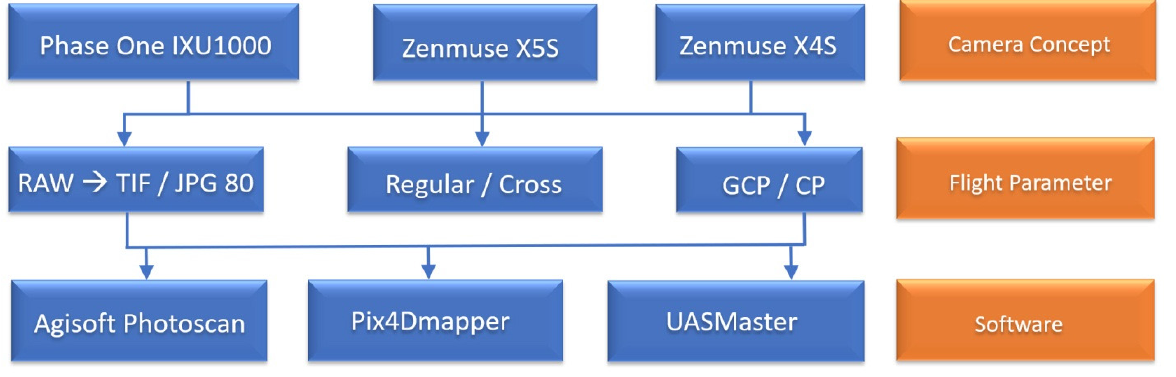
Figure 5. Parameters influencing the geometric quality of the image